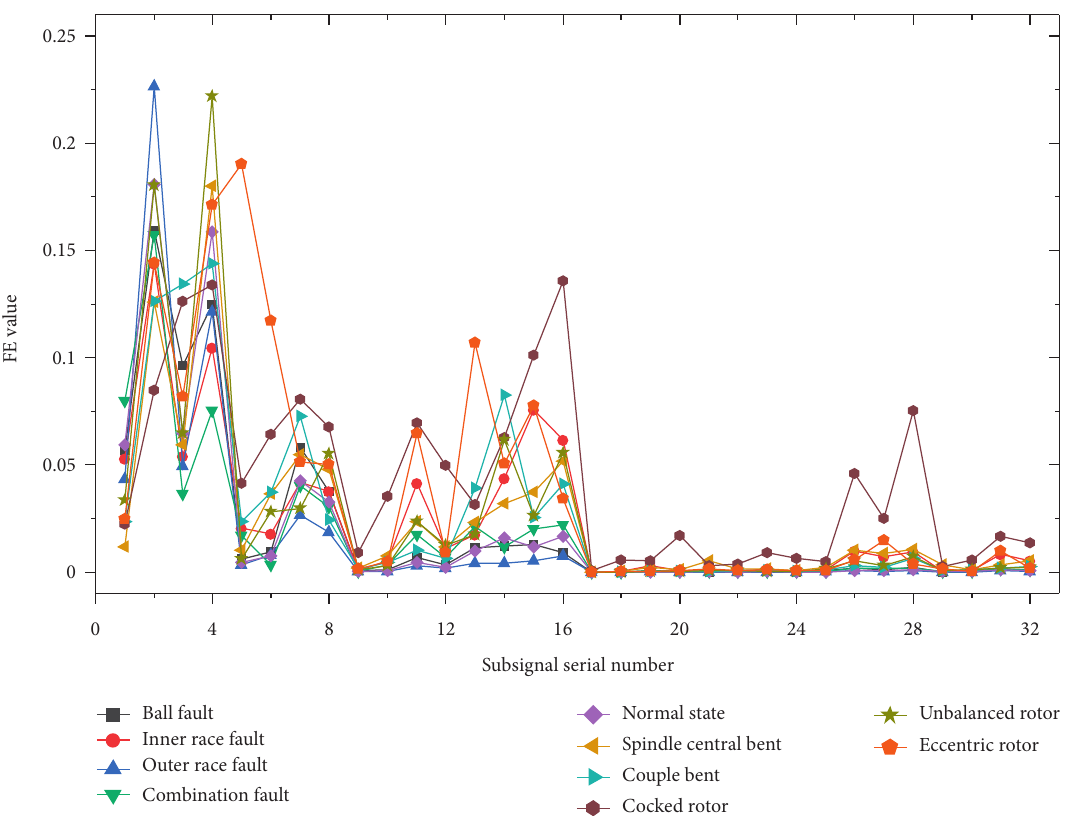
Figure 6: The FE values of subsignals decomposed by